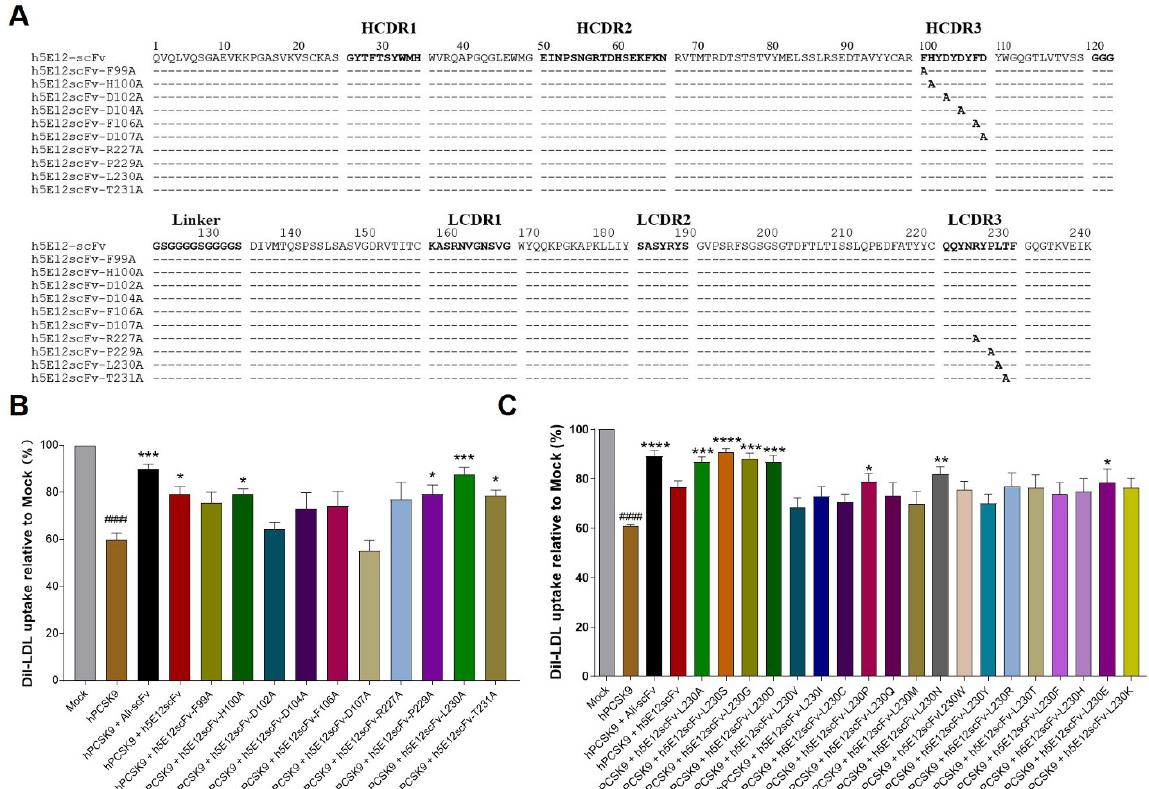
Figure 5. Affinity maturation and selection of h5E12scFv in vitro. ( A ) Alignment of the amino acid sequences of h5E12scFv with its corresponding alanine-scanning variants. Dashes (-) represent the same residue as h5E12scFv. ( B ) Effect of the alanine-scanning mutants of h5E12scFv on PCSK9-mediated inhibition of LDL-C uptake in HepG2. The result revealed that L230 was not necessary for maintaining h5E12scFv’s activity and its modification might improve the hPCSK9 inhibitory effect of h5E12scFv. ( C ) Effect of the saturated mutagenesis variants of h5E12scFv on PCSK9-mediated inhibition of LDL-C uptake in HepG2. The result showed that h5E12scFv-L230S was the most potent hPCSK9 inhibitor among all the h5E12scFv variants. ### p < 0.001, #### p < 0.0001 vs. Mock group; * p < 0.05, ** p < 0.01, *** p < 0.001, **** p < 0.0001 vs. hPCSK9 group. Data are means ± SEM of 3 independent experiments.